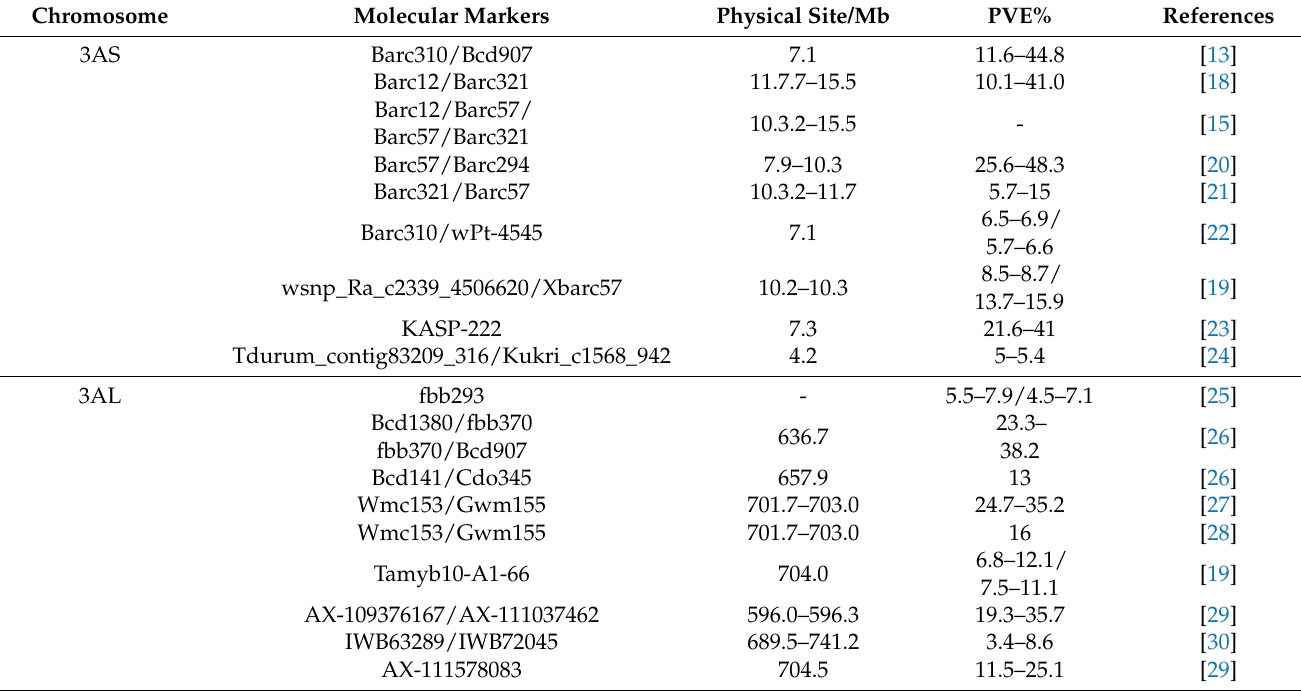
Table 1. The quantitative trait loci for pre-harvest sprouting resistance on chromosomes 3A and 4A. Chromosome Molecular